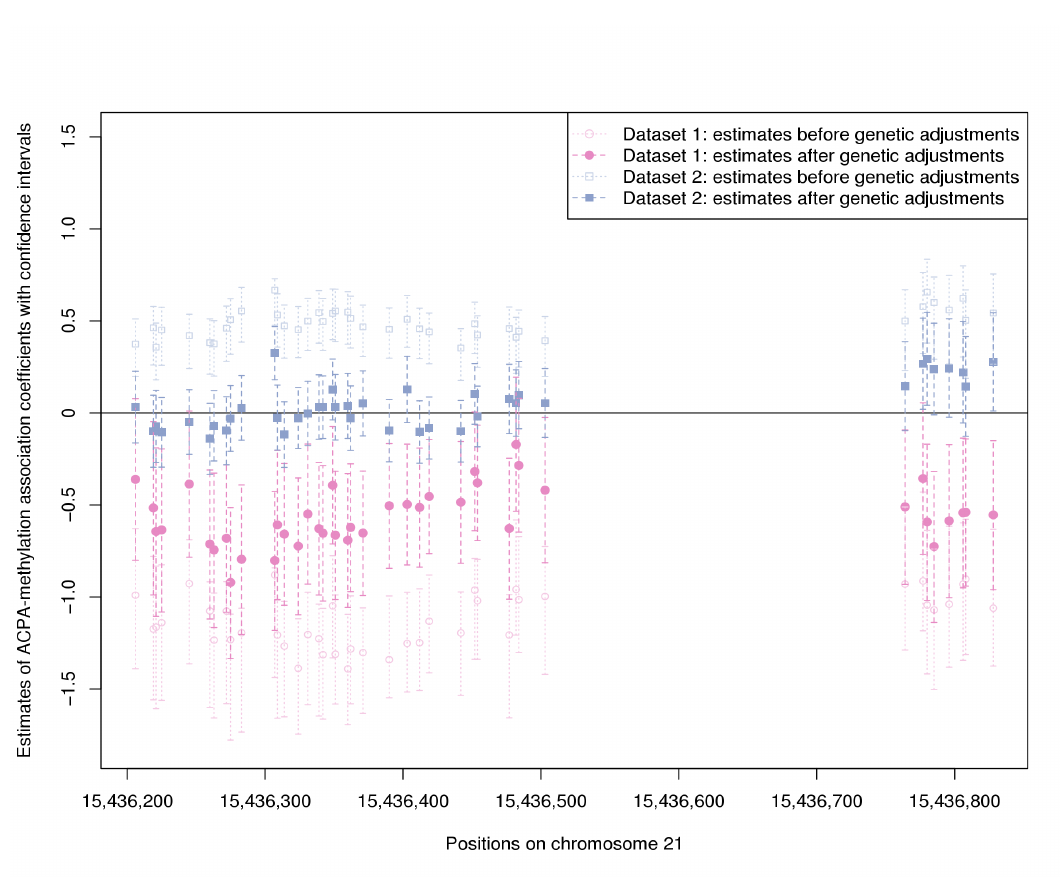
Figure 5. Estimated coefficients and confidence intervals for association between methylation and ACPA status from binomial regressions in Dataset 1 and Dataset 2, with and without inclusion of meQTL